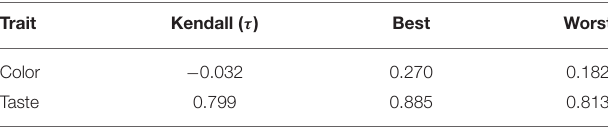
TABLE 6 | Correlation between rankings provided for overall acceptability (OA), Color and Taste assessed in Uganda. Trait Kendall ( τ